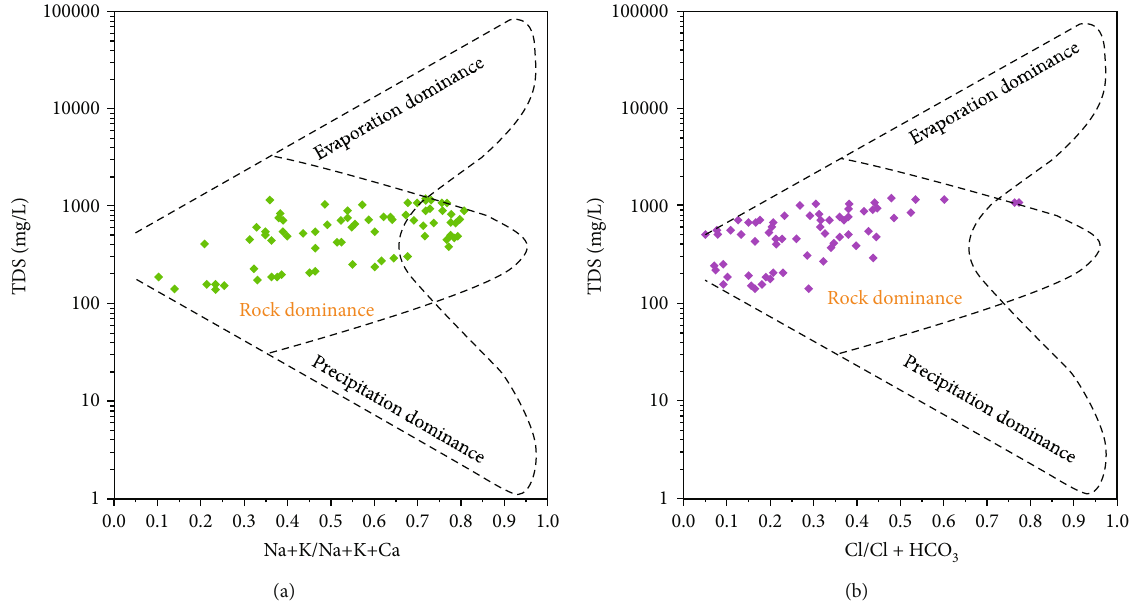
Figure 4: Gibbs plot showing the major processes controlling groundwater chemistry of the study